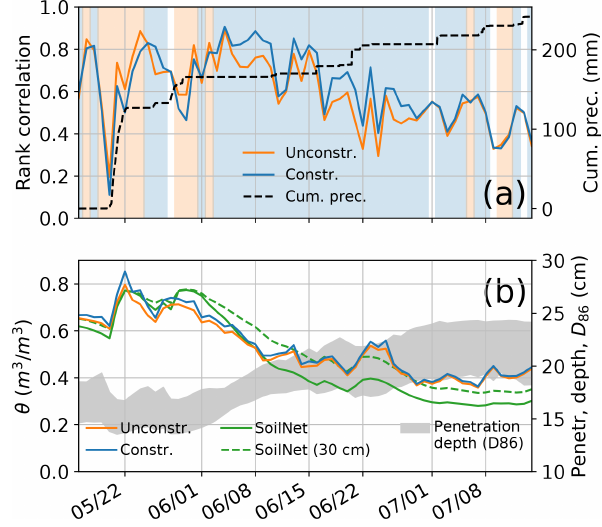
Figure 9. (a) The orange (blue) line shows the rank correlation between the daily average soil moisture pattern of the SoilNet and the pattern from the unconstrained (constrained) interpolation of θ(N) ; blue/orange backgrounds highlight days on which one model outperforms the other; the dashed black line shows the cu- mulative precipitation. (b) Average daily soil moisture across the SoilNet area as obtained from unconstrained/constrained interpo- lation (orange/blue), the vertically weighted SoilNet observations (solid green), and an unweighted vertical average of the upper 30cm (dashed green); the grey shading represents the range of penetration depths (D86, the depth within which 86% of neutrons probed the soil) in the footprints from the six CRNS sensors closest to the Soil- Net area (CRNS 3, 8, 17, 18, 24,